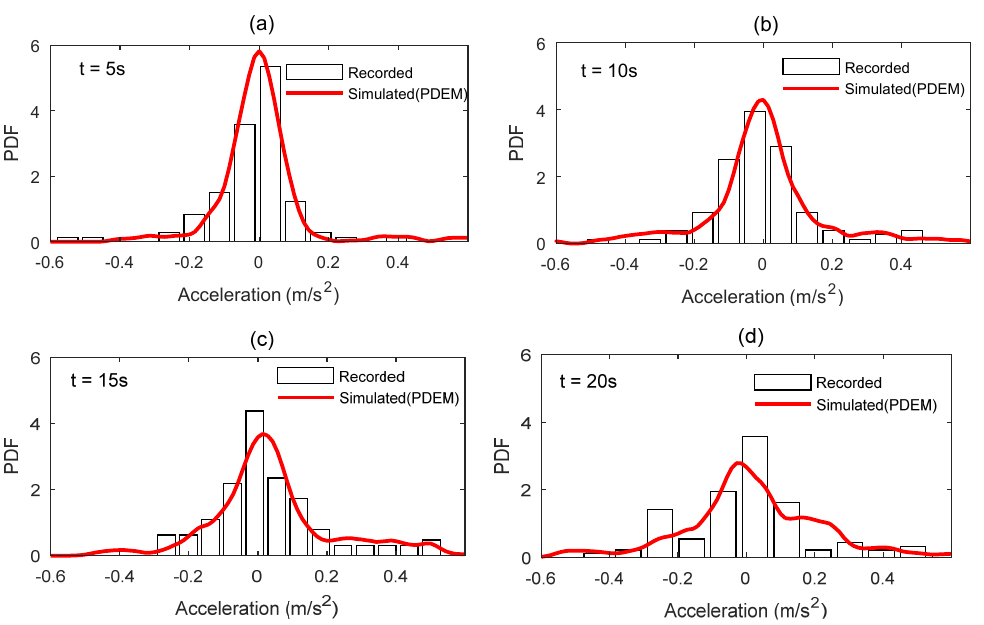
Figure 6. Comparison between the statistical histogram of recorded seismic ground motions and PDF of simulated seismic ground motions calculated by PDEM at typical instants. ( a ) 5 s; ( b ) 10 s; ( c ) 15 s; ( d ) 20 s.